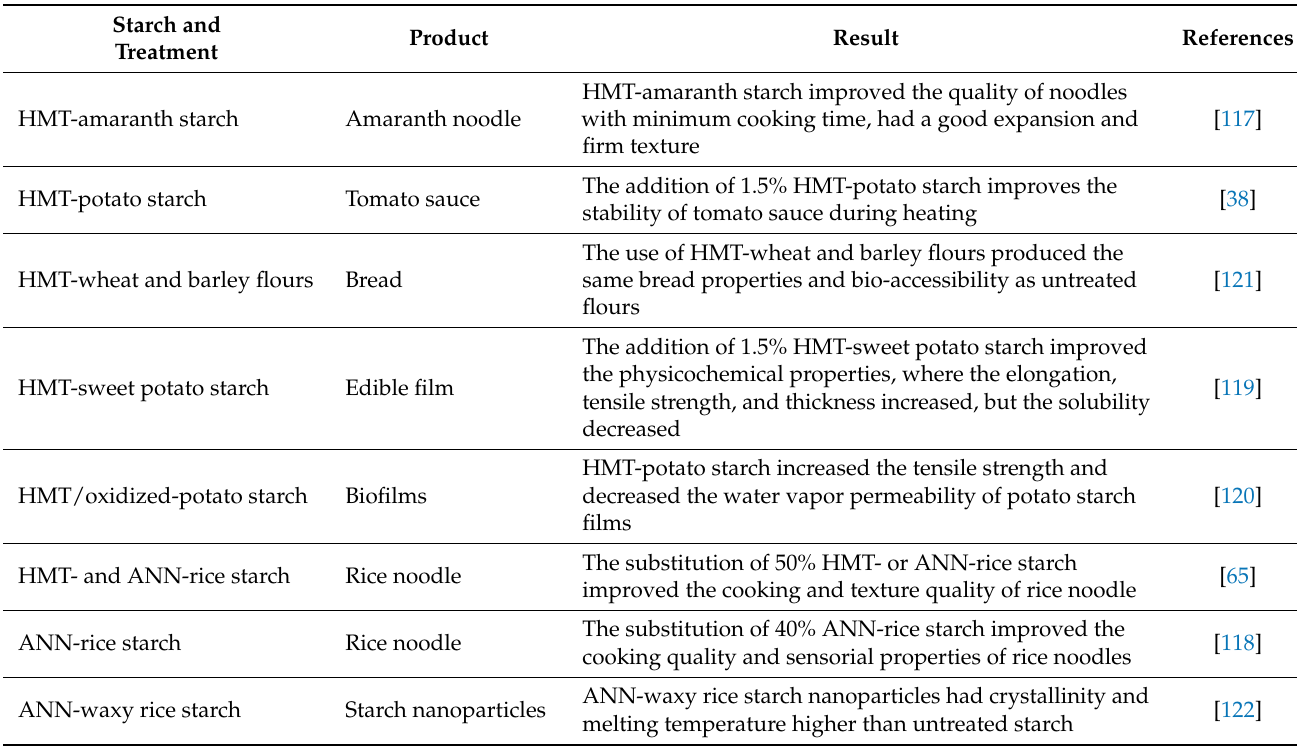
Table 6. Some applications of hydrothermal-treated starch and flour (HMT and ANN) for food